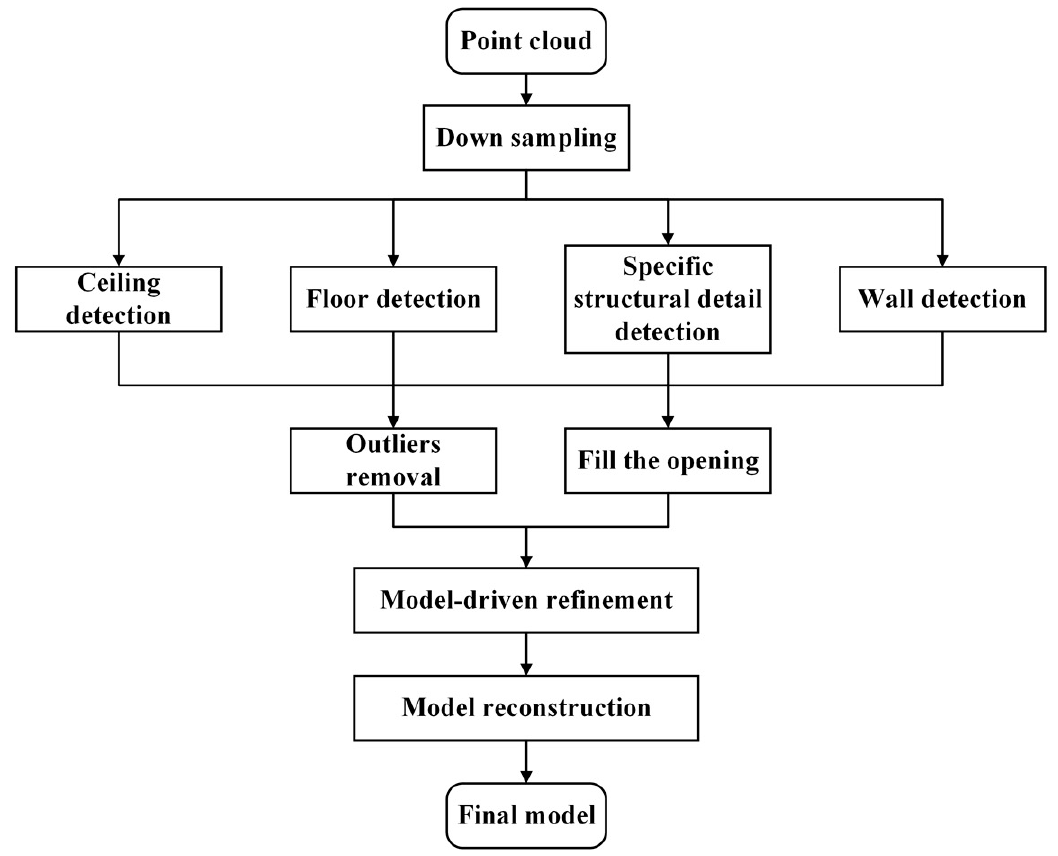
Figure 2. Flowchart of the proposed structural elements detection and reconstruction (SEDR) approach.